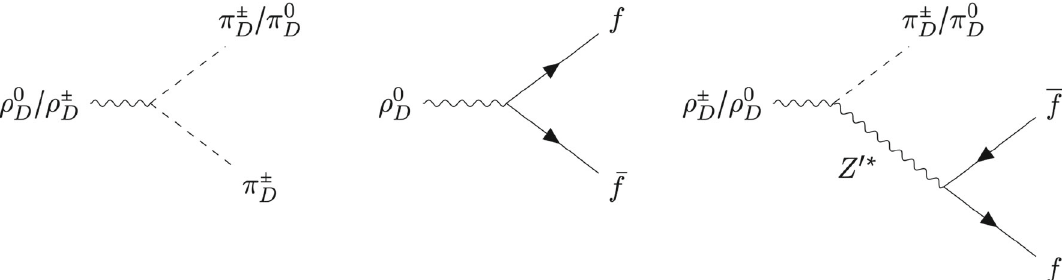
Fig. 23 Decay modes of diagonal and off-diagonal dark rho mesons for regime 1 (left hand side) and regime 2 (middle and right hand